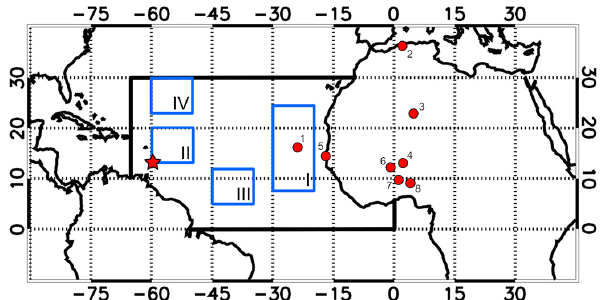
Figure 2. The areas of interest for this study. The large black rect- angle encloses the region covered by the satellite-derived monthly dust AOD data set and the blue rectangles (labelled with roman nu- merals) are the regions within which model and satellite DAOD are compared. These are referred to as (I) coastal Africa, (II) Caribbean, (III) South America and (IV) North Atlantic. Numbered circles in- dicate the location of AERONET sites used and the star shows the location of the surface concentration measurements in